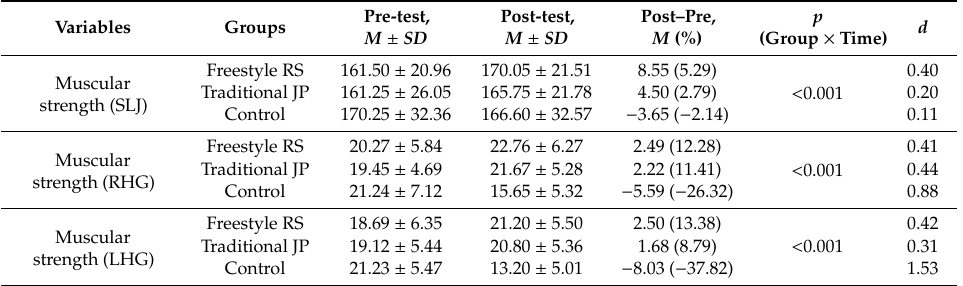
Table 3. Descriptive results of study variables between pre-test and post-test ( N = 60). Variables